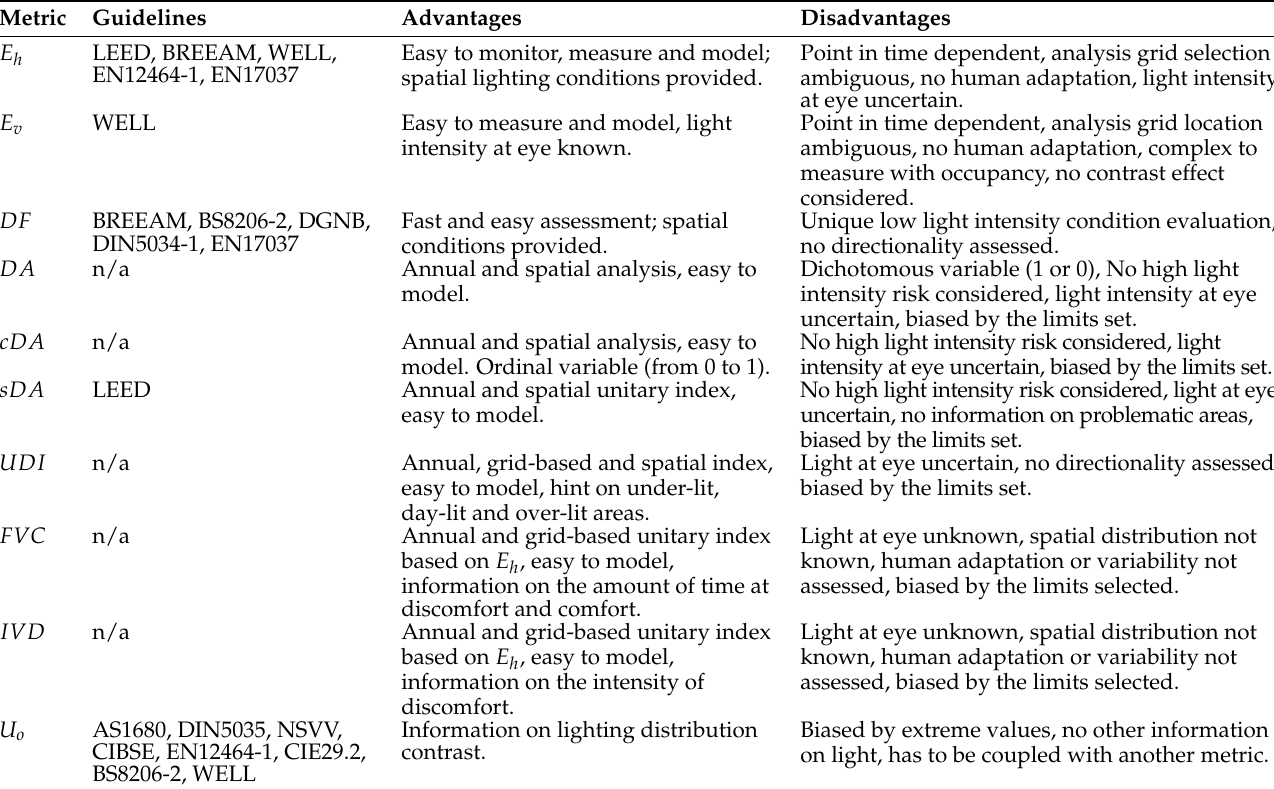
Table 2. Critical analysis summary of collected visual comfort condition metrics based on daylight intensity and distribution, highlighting their benefits and drawbacks.